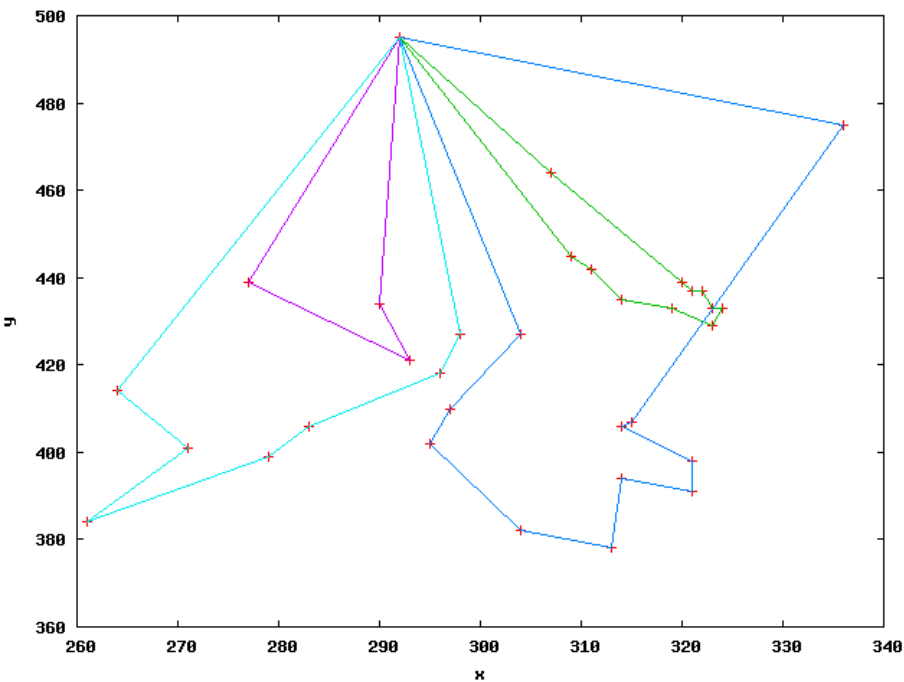
Figure 12. Crossover domination experiment—example for medium Christophides and Eilon set E, fitness distance from the best-known one around 0.97%.